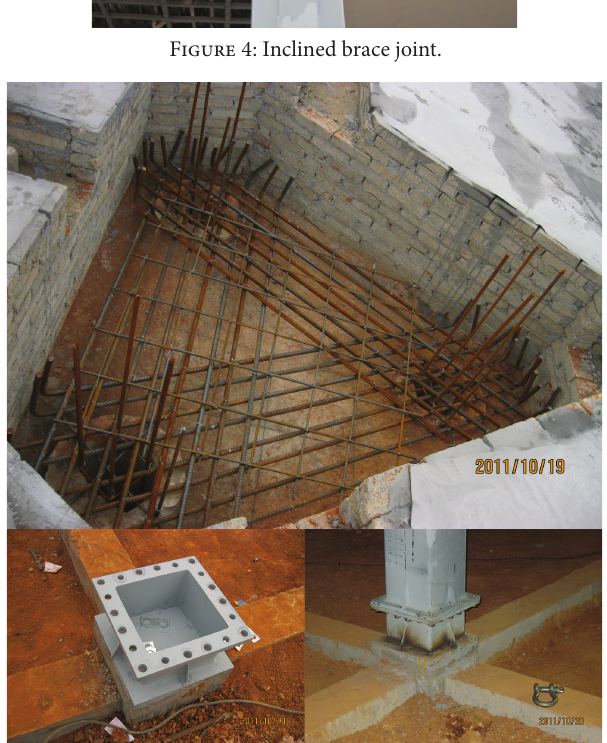
Figure 5: Foundation and connection.